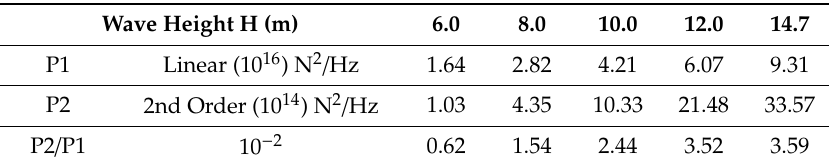
Table 7. Nonlinearity of regular wave.